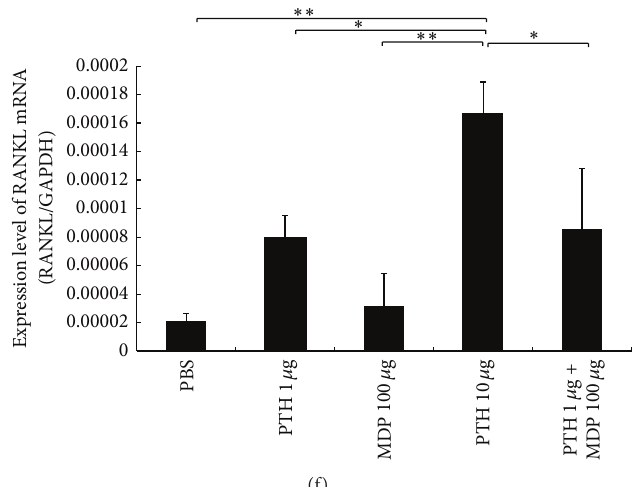
Figure 6: Effects of muramyl dipeptide (MDP) on parathyroid hormone- (PTH-) induced osteoclast formation in vivo . (a) Histological sections of sutures of calvariae were obtained from mice after 5 days of daily supracalvarial administration with PBS (A), 1 𝜇 g/day PTH (B), 100 𝜇 g/day MDP (C), 10 𝜇 g/day PTH (D), or 1 𝜇 g/day PTH and 100 𝜇 g/day MDP (E). Sections were stained with tartrate-resistant acid phosphatase (TRAP) staining and counterstained with hematoxylin. Cells that stained red are considered to be TRAP-positive. Scale bars = 50 𝜇 m. (b) Number of TRAP-positive cells with three or more nuclei in the calvariae ( 𝑛 = 4 ; ∗∗ 𝑃 < 0.01 ). (c) Histological sections of calvariae were obtained from mice after 5 days of daily supracalvarial administration with PBS (A), 1 𝜇 g/day PTH (B), 100 𝜇 g/day MDP (C), 10 𝜇 g/day PTH (D), or 1 𝜇 g/day PTH and 100 𝜇 g/day MDP (E). Sections were stained with tartrate-resistant acid phosphatase (TRAP) staining and counterstained with hematoxylin. Cells that stained red are considered to be TRAP-positive. Scale bars = 100 𝜇 m. (d) The percentage of bone/marrow interface covered by osteoclasts was histomorphometrically determined in specimens ( 𝑛 = 4 ; ∗∗ 𝑃 < 0.01 ). (e) TRAP and cathepsin K mRNA levels in mouse calvariae were detected using real-time RT-PCR. Total RNA from mouse calvariae was isolated after 5 days of daily supracalvarial injections, as in (a). RNA levels for TRAP and cathepsin K were normalized to those of GAPDH. Results are expressed as the mean ± SD ( 𝑛 = 4 ; ∗∗ 𝑃 < 0.01 ; ∗ 𝑃 < 0.05 ). (f) Expression levels of RANKL mRNA in mouse calvariae in vivo . Total RNA from mouse calvariae was isolated after 5 days of daily supracalvarial injections, as in (a). mRNA levels for RANKL were normalized to those of GAPDH. Results are expressed as the mean ± SD ( 𝑛 = 4 ; ∗∗ 𝑃 < 0.01 ; ∗ 𝑃 < 0.05 ). Differences were determined using Scheffe’s 𝐹 test.